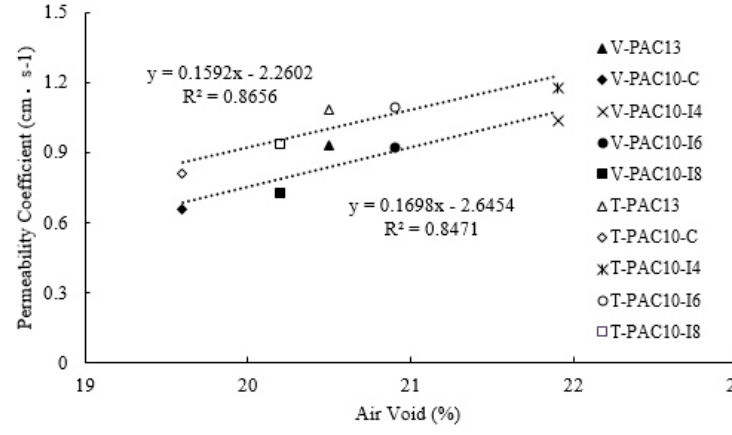
Figure 7. Results of permeability tests.